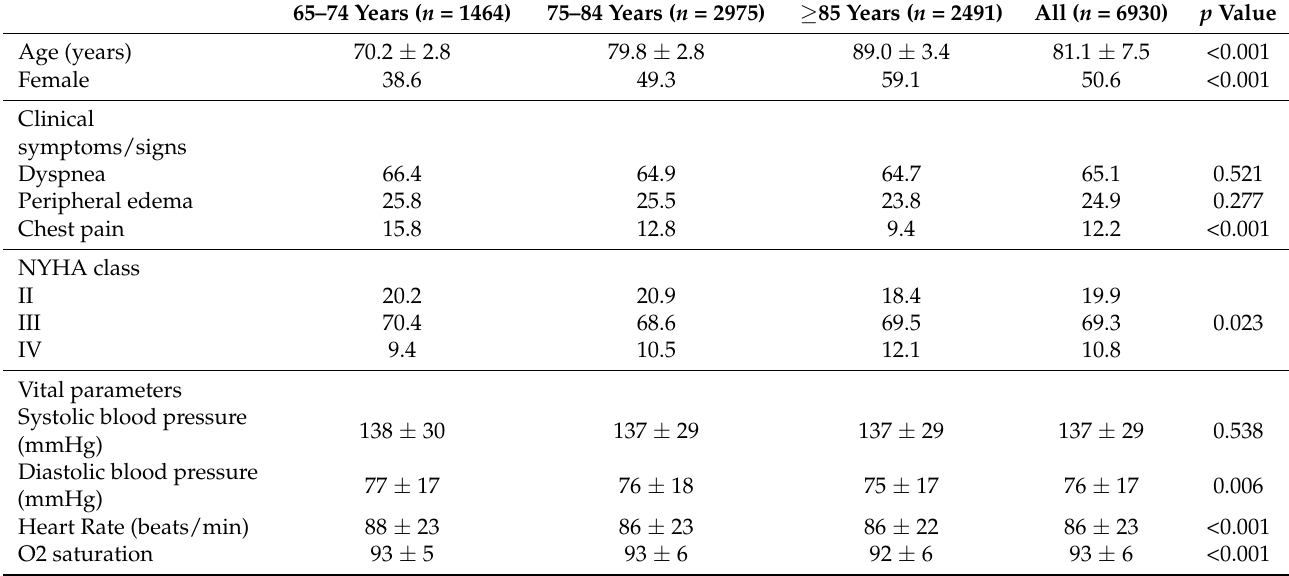
Table 1. Demographic and clinical characteristics of patients by age